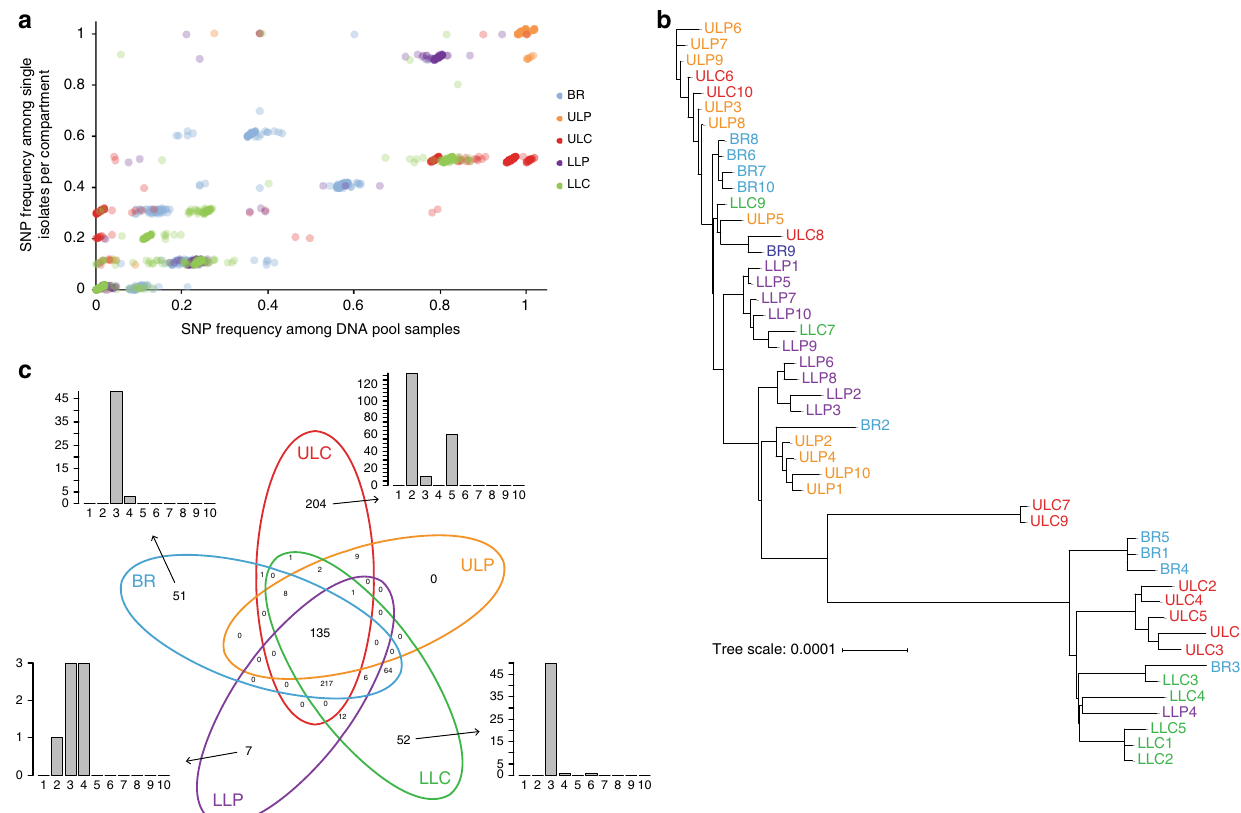
Fig. 3 Genome sequencing of single isolates and pools. a The single-nucleotide polymorphism (SNP) frequency in 10 single isolates per compartment was correlated to the SNP frequencies in the pools (mean of two replicates) of the respective compartment. The overall linear association between the detection of SNPs in single genome vs. pooled genome sequencing was high (Pearson ’ s correlation coef fi cient r = 0.924, adjusted p value ≤ 0.001). Slight jitter was added to increase visibility (up to 2% change). b Genomes from single isolates were de novo assembled and the phylogenetic tree was created based on a multi-FASTA alignment of all of the core genes using PRANK. The phylogenetic tree was visualized with the iTOL online tool. Color code of the lung isolates indicates from which sub-compartment they were recovered: main bronchus = blue, upper lobe central = red, upper lobe peripheral = orange, lower lobe central = green and lower lobe peripheral = purple. c Venn diagram of the distribution of the 770 identi fi ed SNPs in the isolates across the fi ve lung compartments. The bar plots indicate the number of the compartment-speci fi c SNPs that are shared by a number of individual isolates among the overall 10 sequenced isolates from each of the compartment. Source data are provided as a Source Data fi